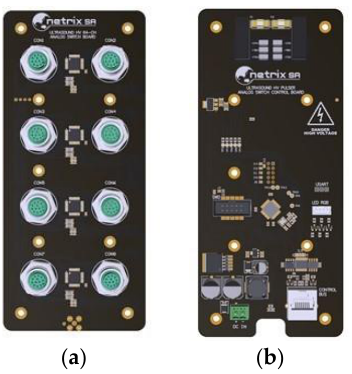
Figure 5. ( a ) Manufactured PCB containing a 64-channel multiplexer and ( b ) high voltage signal generator that drives the ultrasound